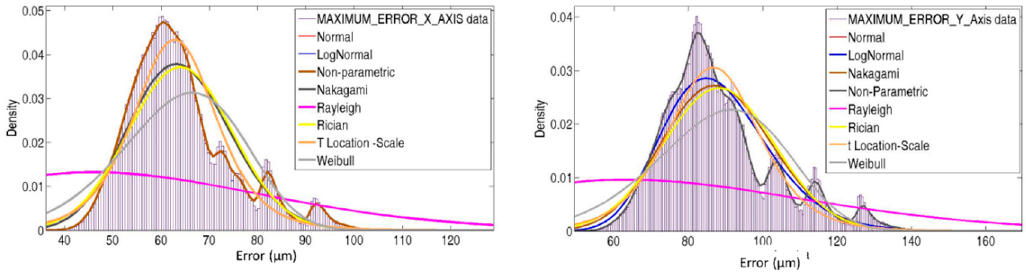
Figure 11. Maximum error for each best LT position.